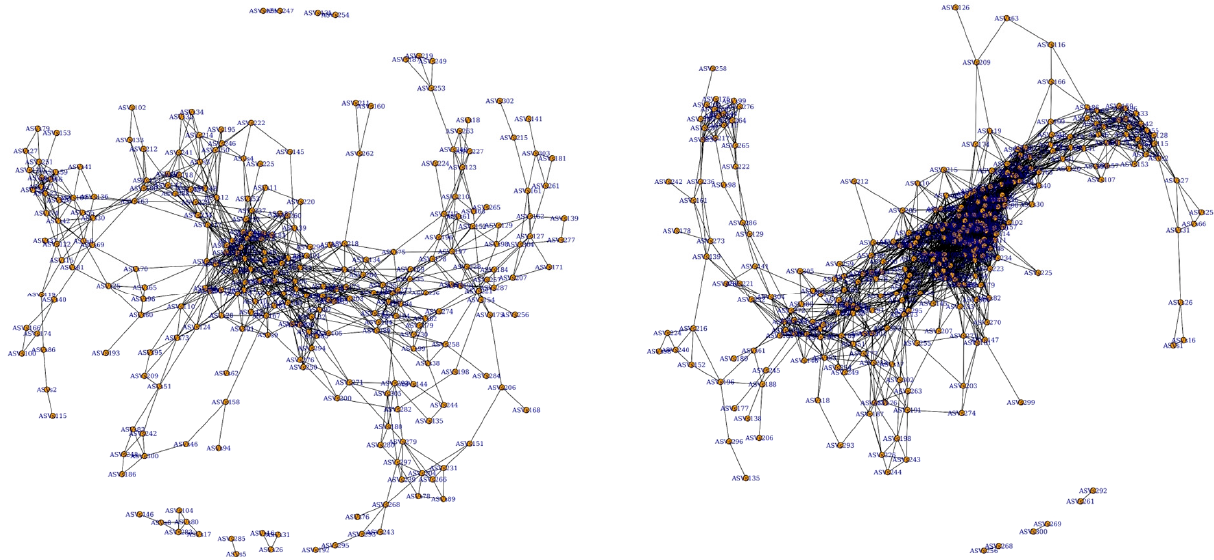
Figure 5. Network analyses carried out on saffron rhizosphere samples in the absence (on the left) and presence (on the right) of fusariosis. Jaccard similarity coefficient: 4.